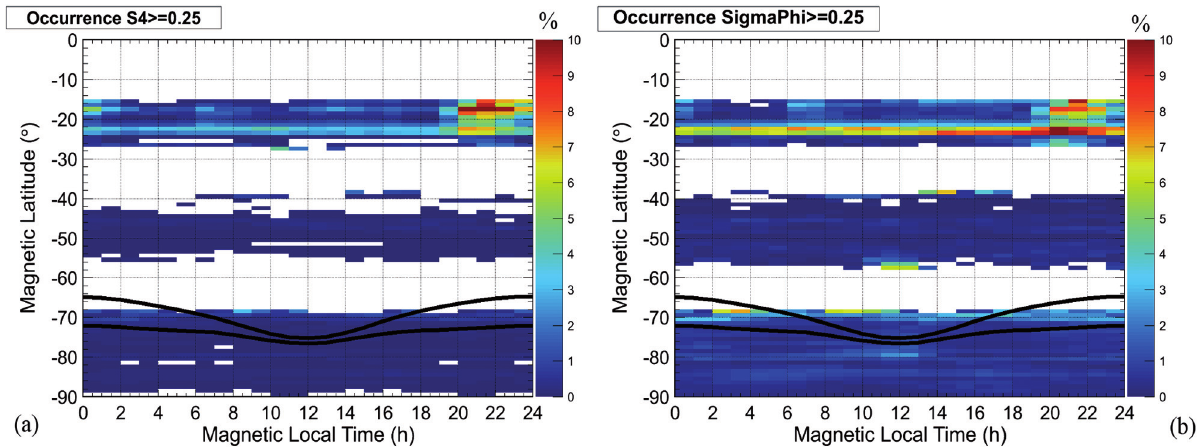
(a) and v U (b) percentages of occurrence above the moderate/ strong scintillation threshold. The black curve is the mod- Figure 5. Maps of S 4 eled Feldstein oval for IQ =